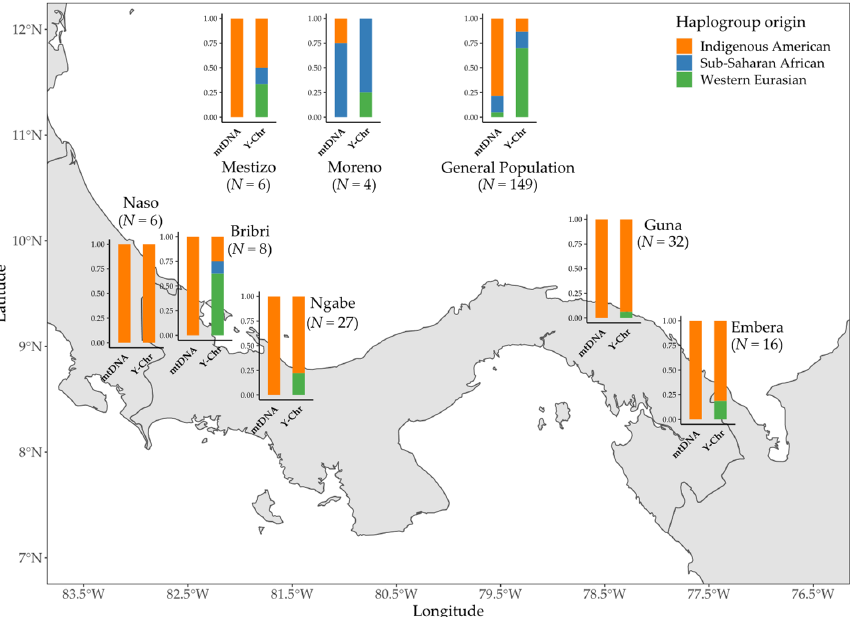
Figure 3. Map showing the distributions of mtDNA and Y-chromosome haplogroup origins (indicated by different colors) among 248 Panamanian males.